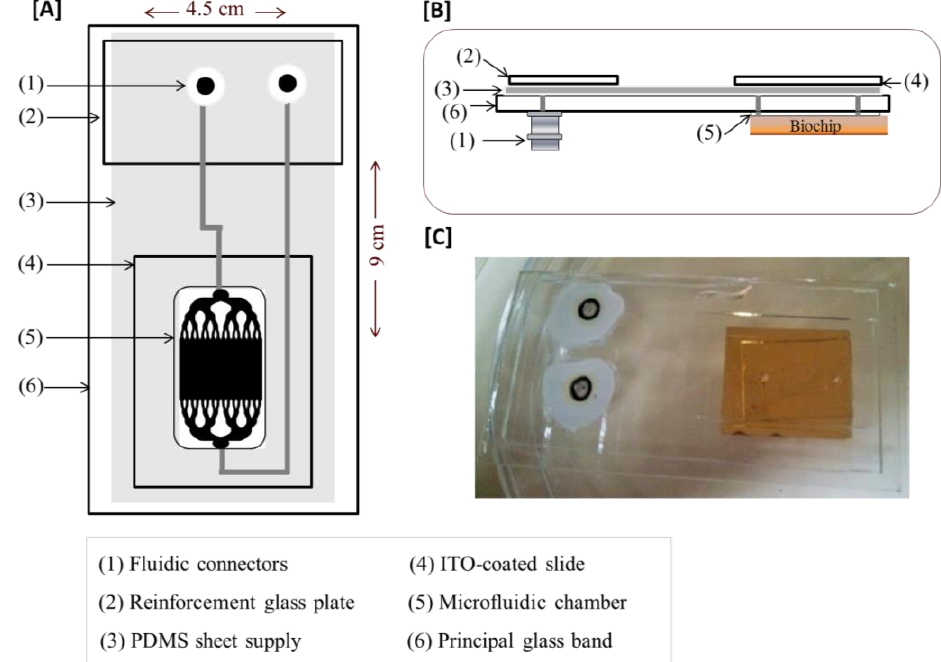
Figure 2. The design of the microfluidic platform integrated with the antibody-based biochip. ( A ) 2D view and presentation of different parts; ( B ) side view; and ( C ) picture of the